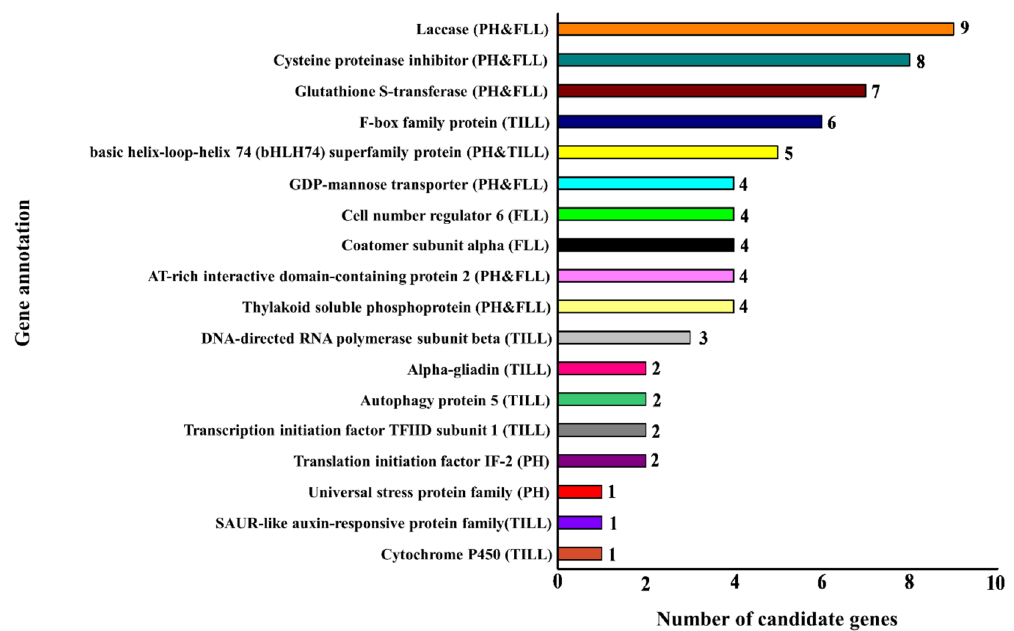
Figure 5. Putative candidate genes responsible for important functions associated with plant architectural traits. PH (Plant height); FLL (flag leaf length); TILL (number of tillers per